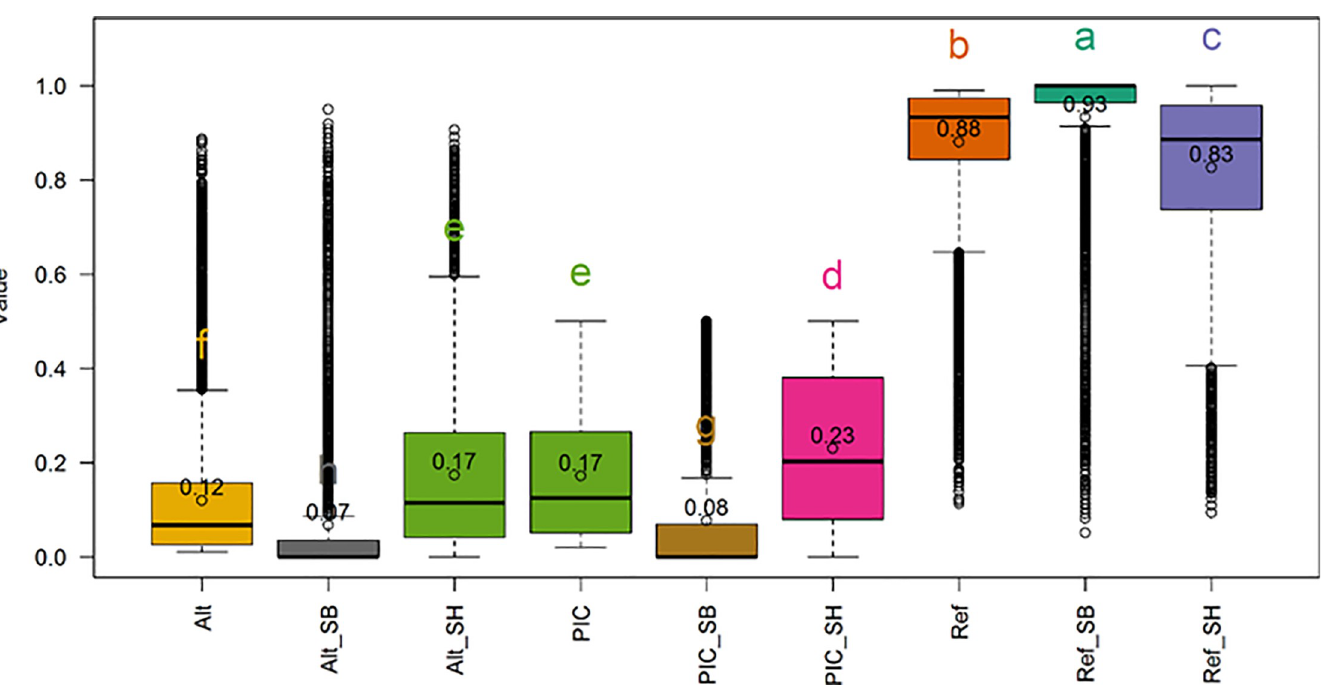
Fig 6. Alternative (Alt) and reference (Ref) allele frequency and polymorphic information content (PIC) per entire panel and subpopulations. Open dot inside the rectangles and the numbers inside or outside the rectangles (interquartile ranges) represent, respectively, the position of mean and the mean of the metric of intertest. The horizontal bar inside the rectangles represents the median value. Means with same letter are not significantly different at the 5% level using the Tukey’s HSD (honestly significant difference)